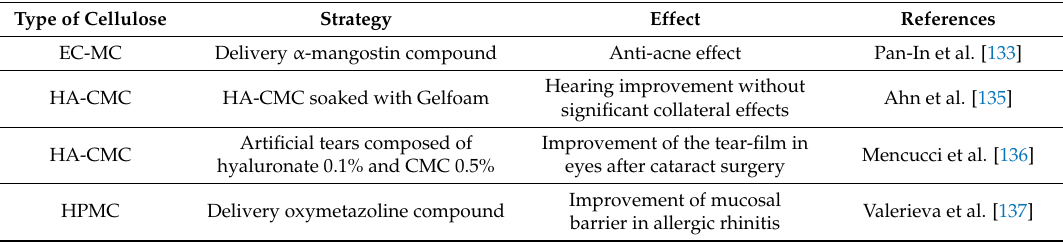
Table 7. Summary of the nano-cellulose-based material tested in clinical